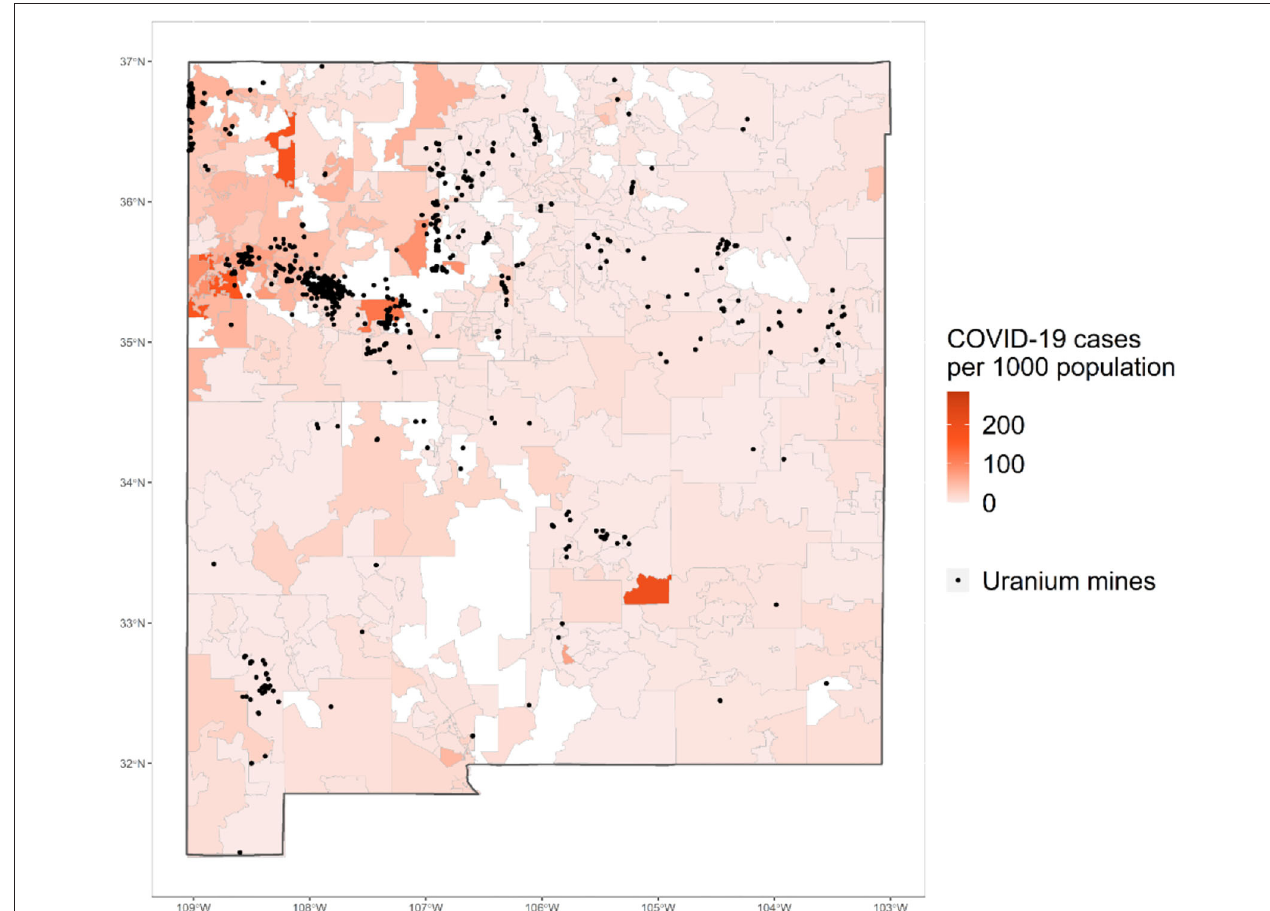
FIGURE 1 | Confirmed COVID-19 cases per 1,000 and abandoned uranium mines in New